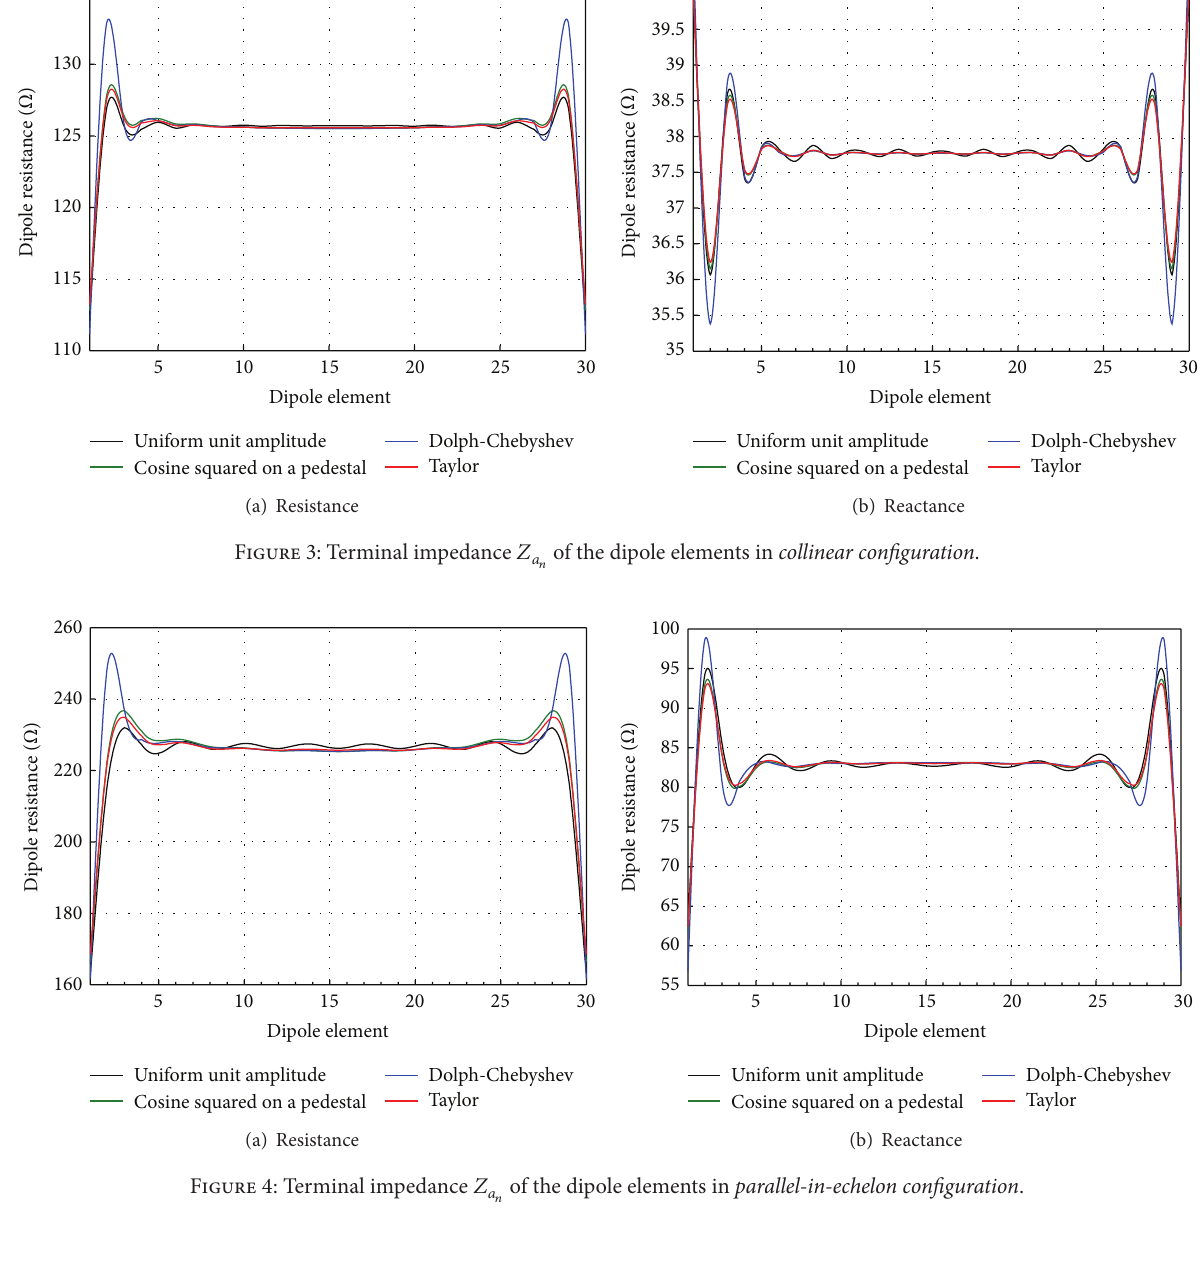
Figure 4: Terminal impedance 𝑍 𝑎